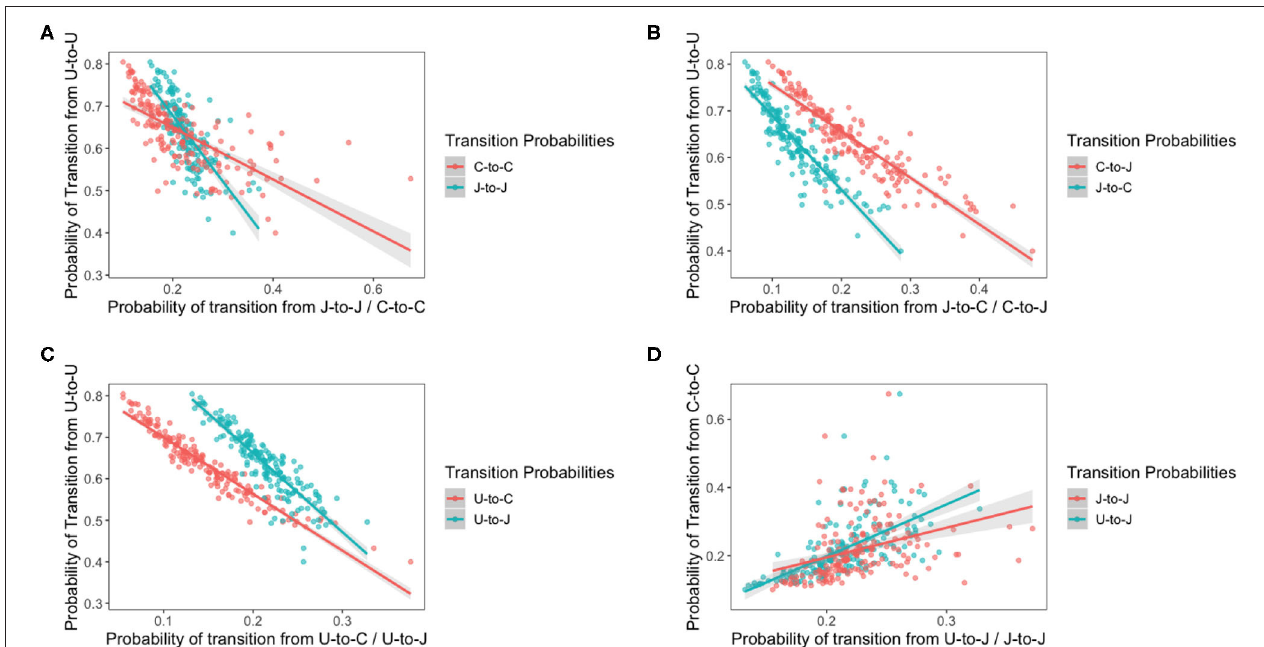
FIGURE 10 | Transition probabilities for a three state system. In these plots, “U” refers to being uncolonized, “J” refers to colonization by C. jejuni and “C” refers to colonization by C. coli . Each of the points is the transition probability for a specific bird within the flock. Linear regression fits are plotted with a shaded region representing the 95% confidence intervals of the regression. All regressions were statistically significant ( t -test p < 0.0001). (A) The transition probabilities of J-to-J and C-to-C against the transition probability of U-to-U. (B) The transition probabilities of C-to-J and J-to-C against the transition probability of U-to-U. (C) The transition probabilities of U-to-J and U-to-C against the transition probability of U-to-U. (D) The transition probabilities of J-to-J and U-to-J against the transition probability of